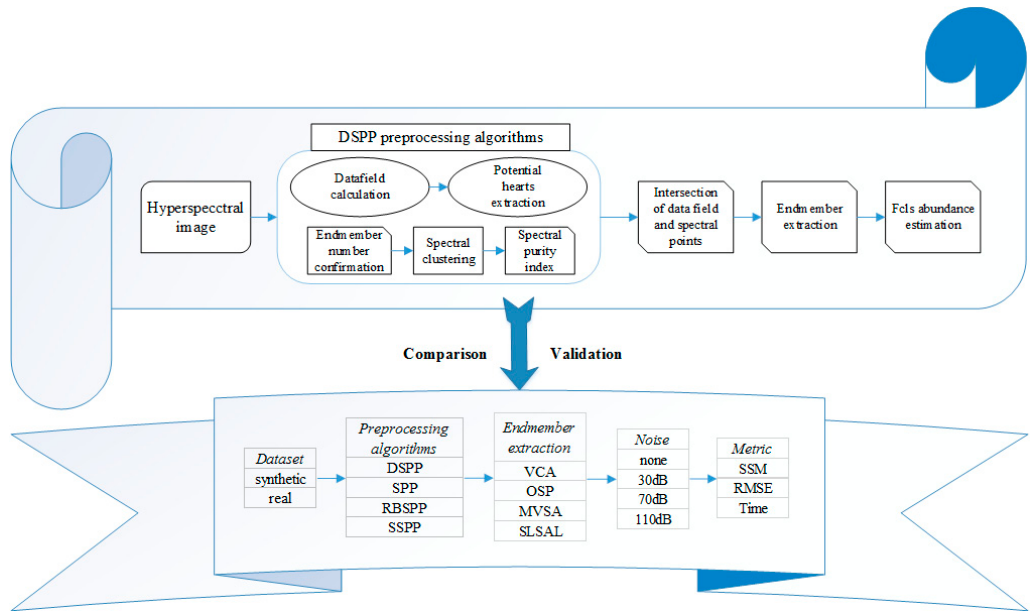
Figure 1. Flowchart of the proposed DSPP algorithm.